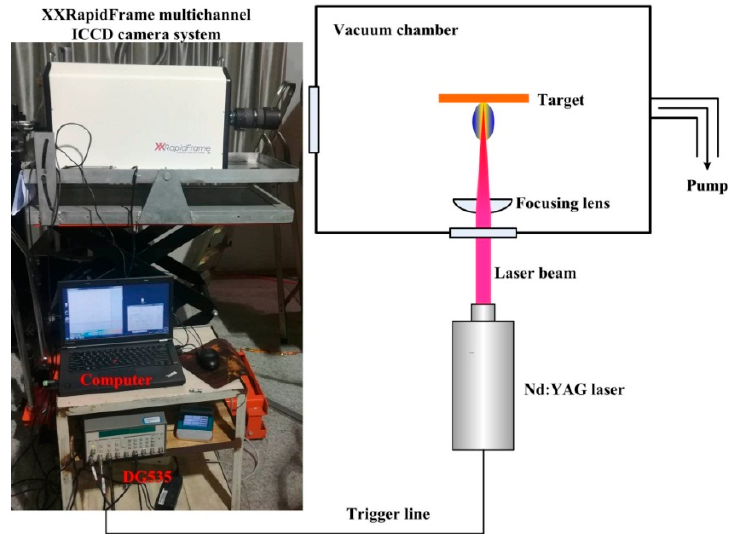
Figure 4. Schematic of the experimental setup.